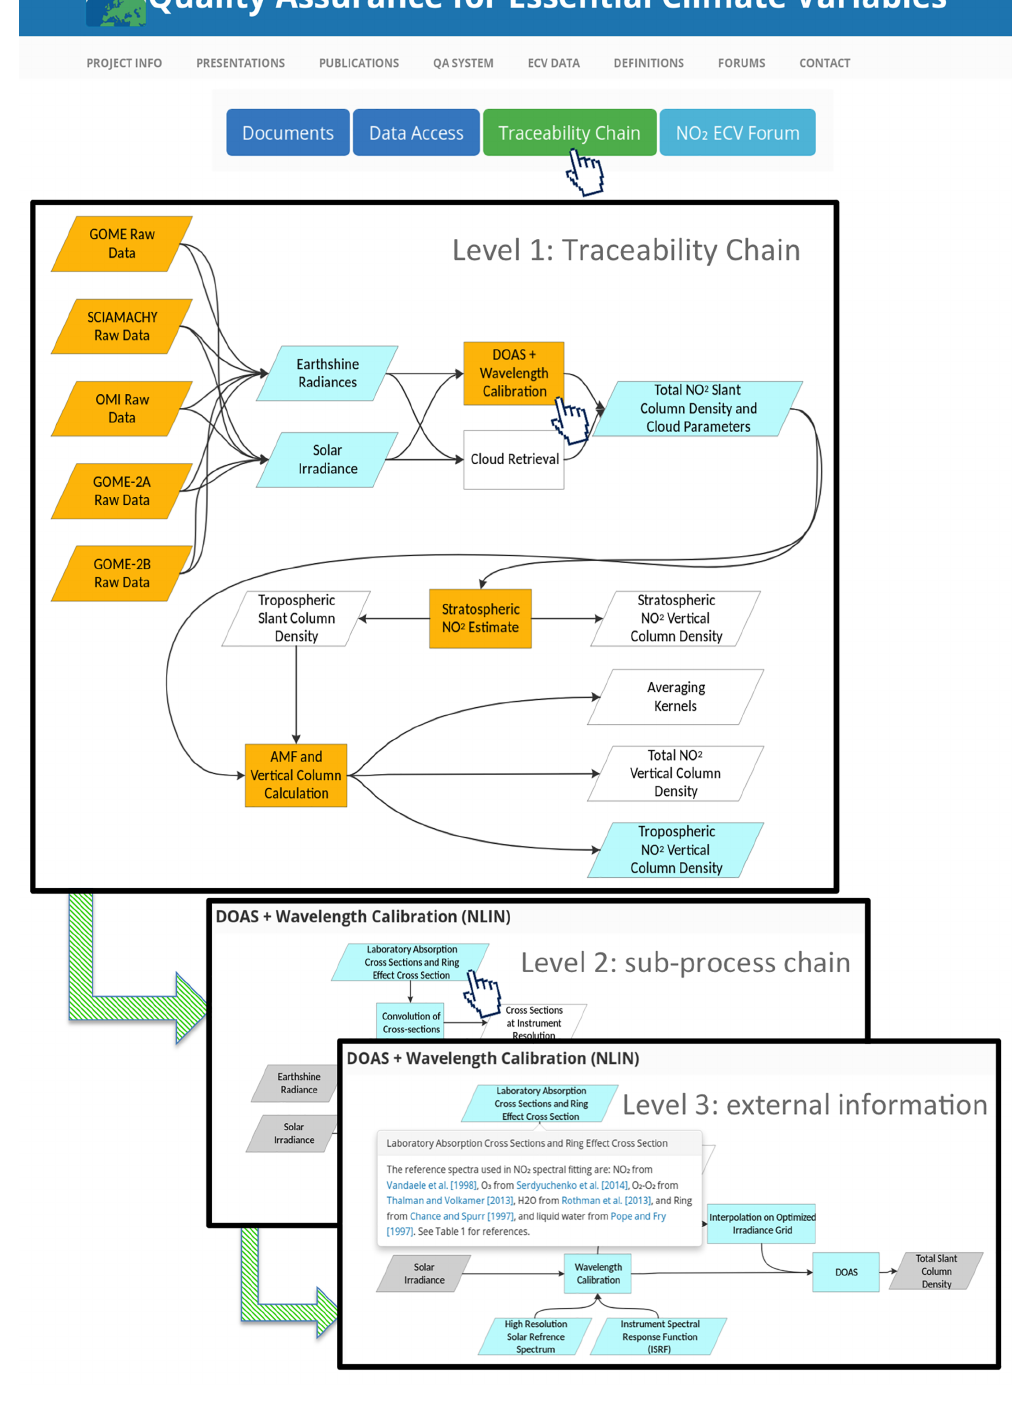
Figure 2. Traceability chain for the QA4ECV NO 2 retrieval algorithm. The orange blocks (rectangles) are the building blocks of the retrieval, and in the main chain these are clickable and show more details in deeper layers. The light-blue blocks are also clickable and will provide more information on that process in a pop-up window. The parallelograms provide information on algorithm choices and input data sets. The interactive traceability chain is available at http://www.qa4ecv.eu/ecv/no2-pre (last access: 13 December